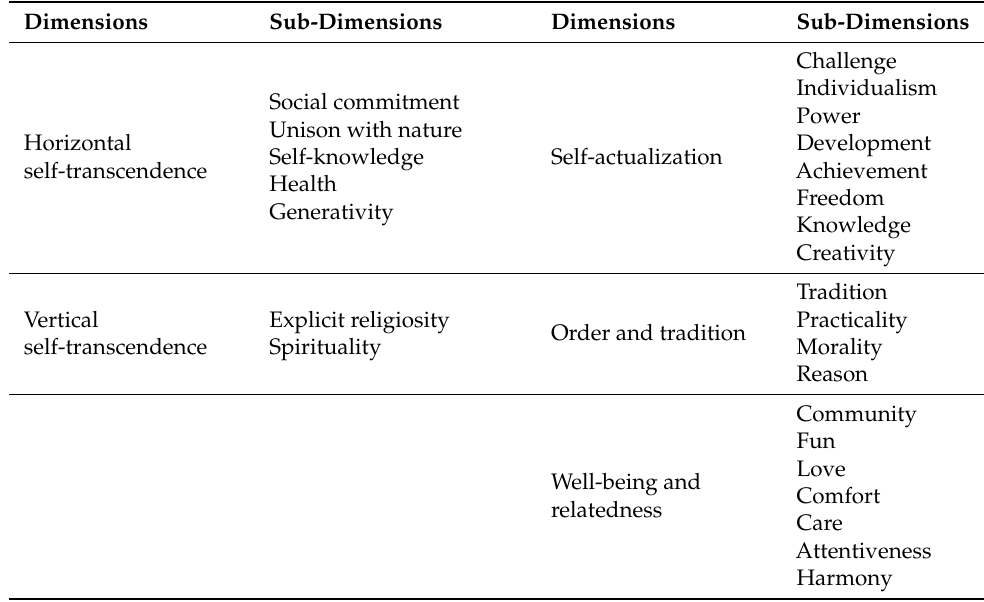
Table 1. Dimensions and sub-dimensions of sources of